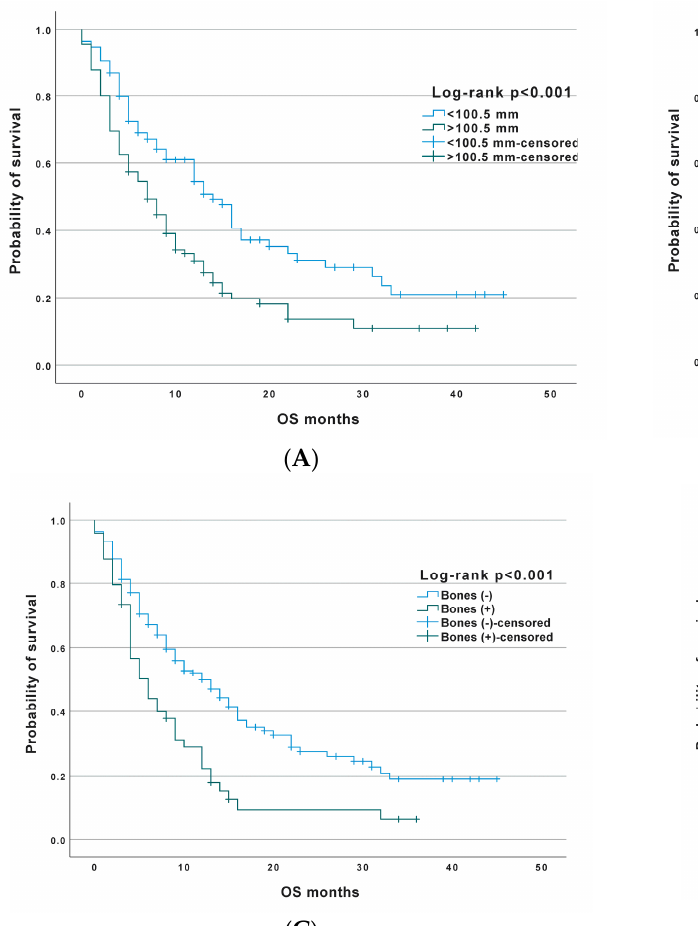
Table 5. Statistics for the variables in the tested model.